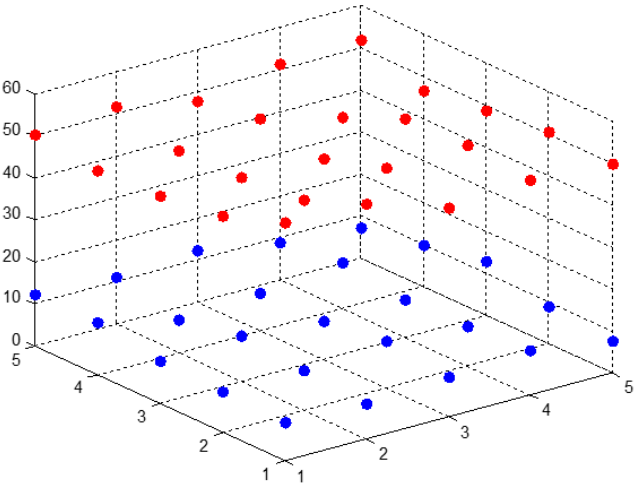
Figure 3. The scatter plot of panel data. The red dots are the panel data points of research object and the blue dots are the panel data points of another research object(these pots don’t link).